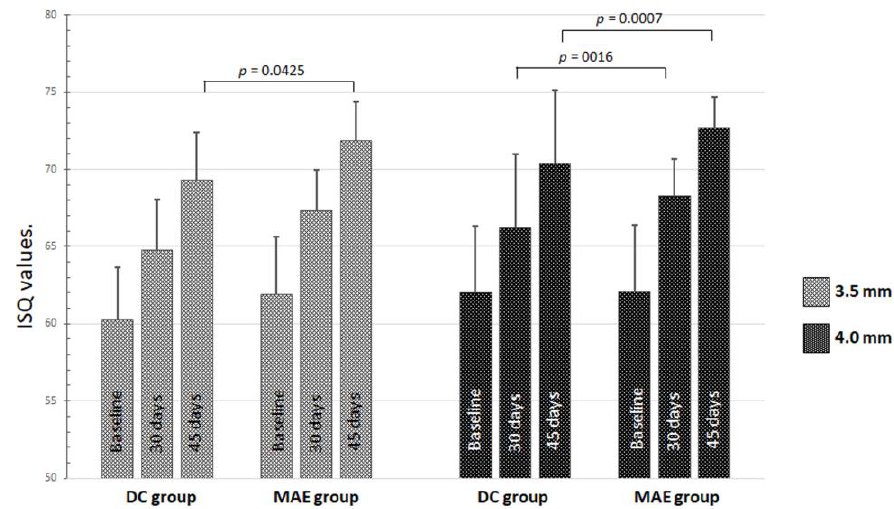
Figure 5. Graph of the data distribution and statistical differences of ISQ values inside and between both groups of implant diameters on the 3 times.